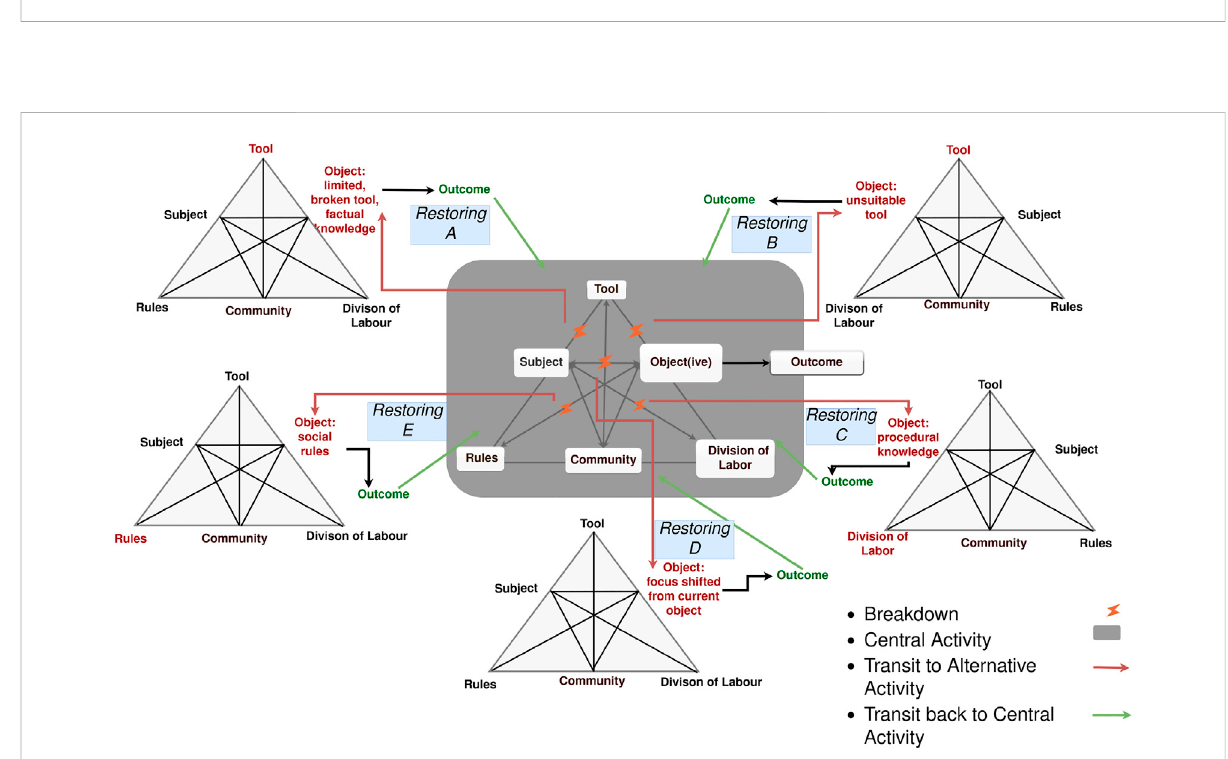
FIGURE 2 Illustration of breakdown situations as focus shift making the agents transition from the central activity to an alternative activity, and then back after the breakdown situation has been resolved (restored) and an outcome has been